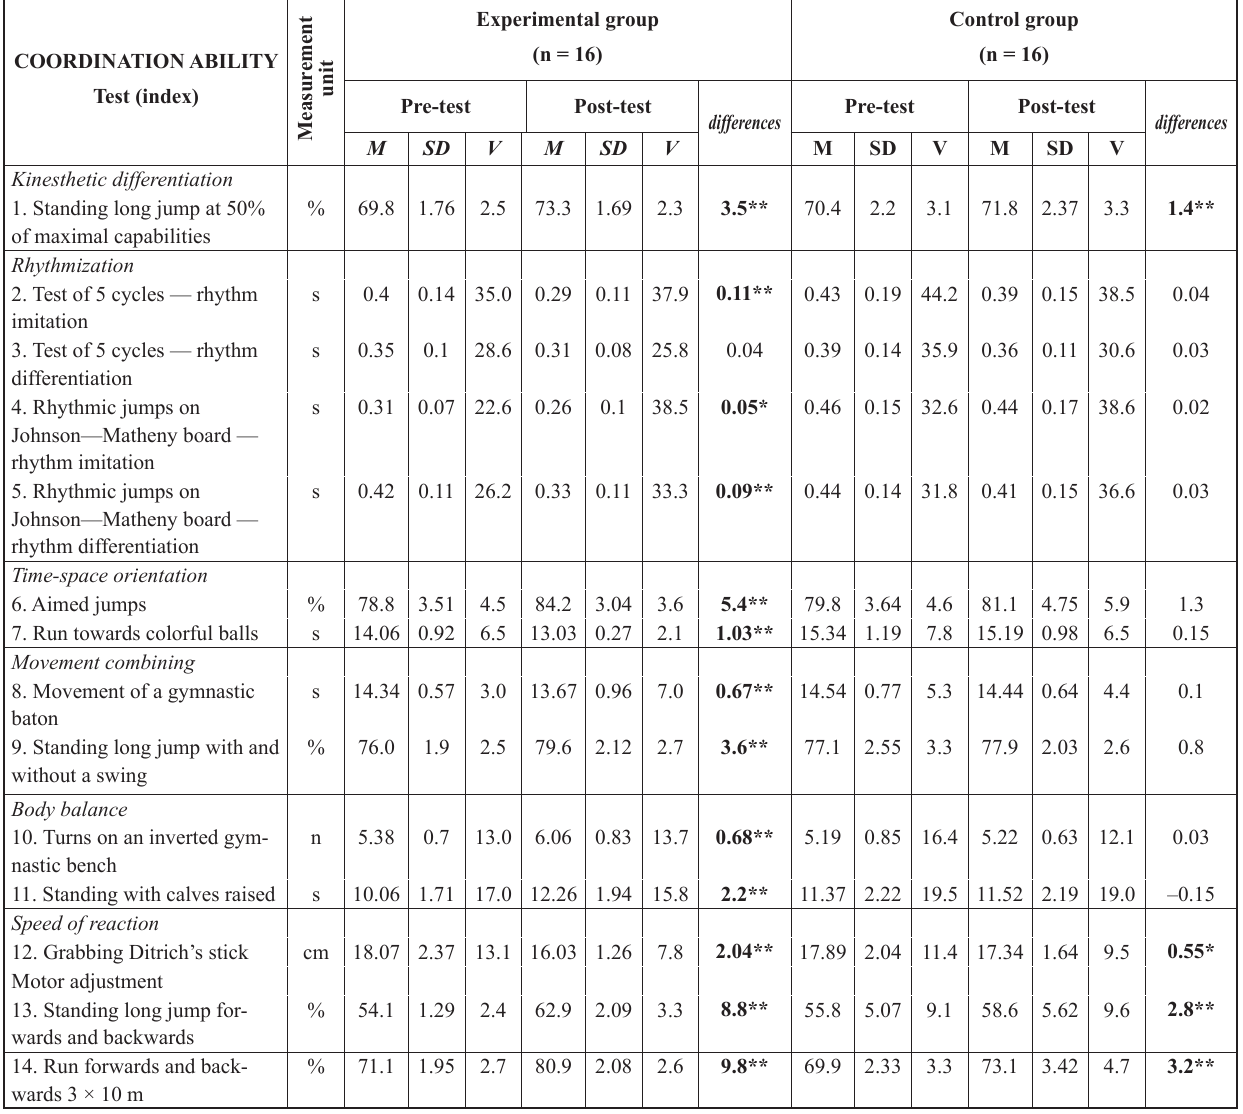
Table 1. Changes in the level of CMA in Greco-Roman wrestlers aged 13—14 after the pedagogical